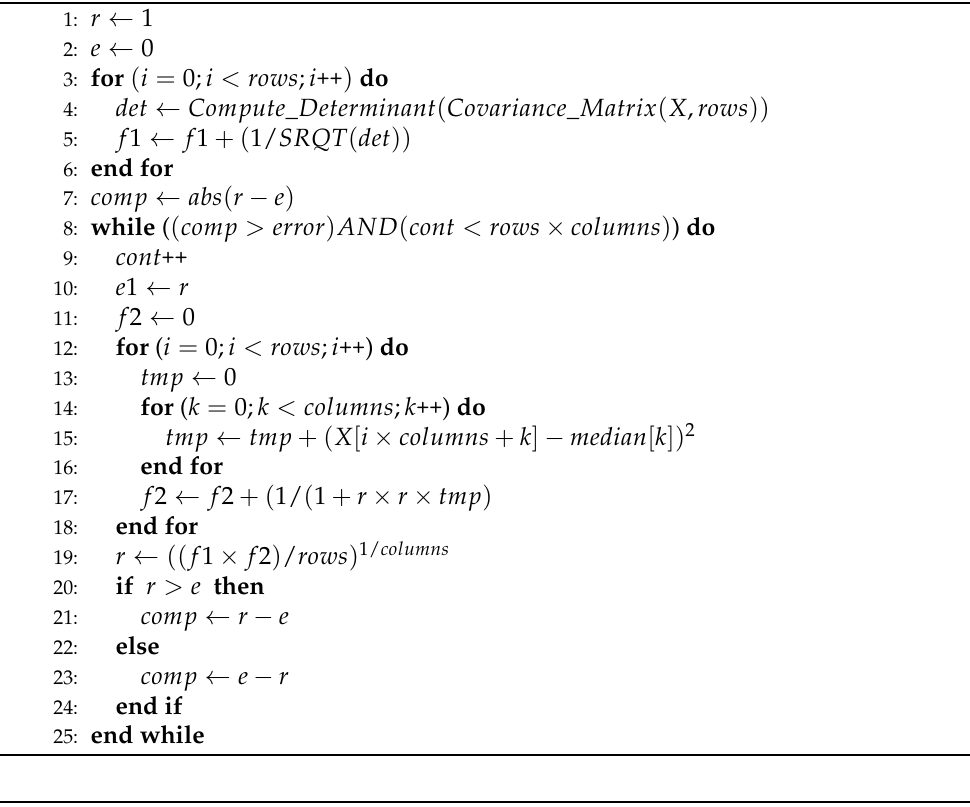
Algorithm 4: Pseudocode for the Calculate _ r _ Factor of the FM algorithm.